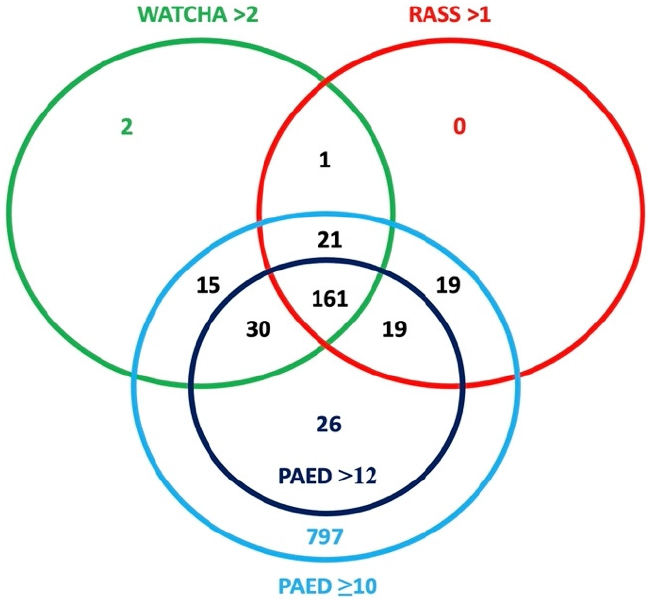
Figure 2. Graphical illustration of the incidence of ED using different scoring systems.